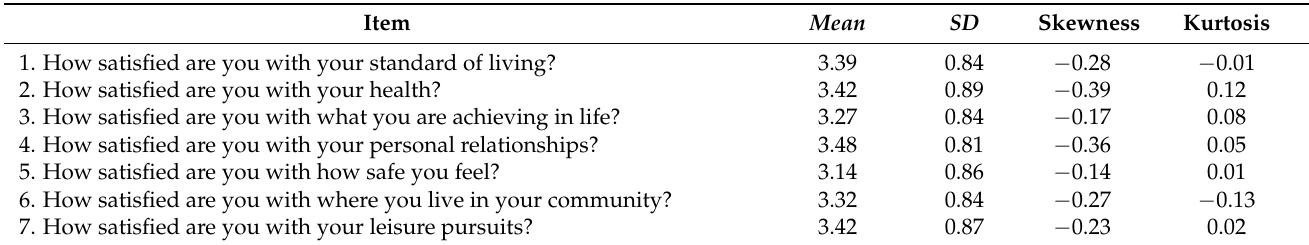
Table A7. Descriptive analysis of wellbeing satisfaction ( n = 605, 2019 sample).